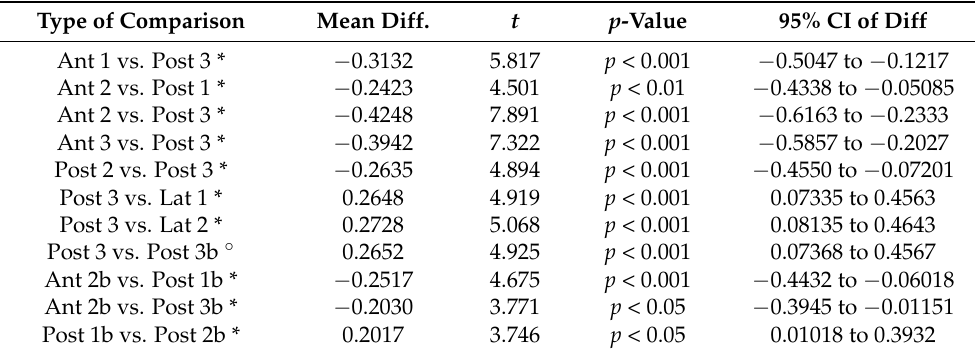
Table 3. Ultrasound measurements comparison within each group and between groups A and B. Only statistically significant differences are